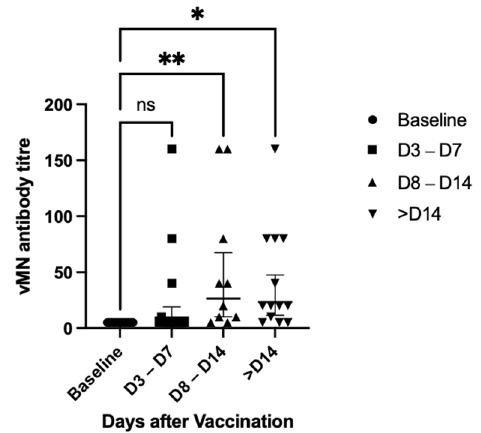
Figure 3. vMN titre against Omicron variant after booster dose, all groups included; * = p < 0.05; ** = p < 0.005; ns = non-significant.